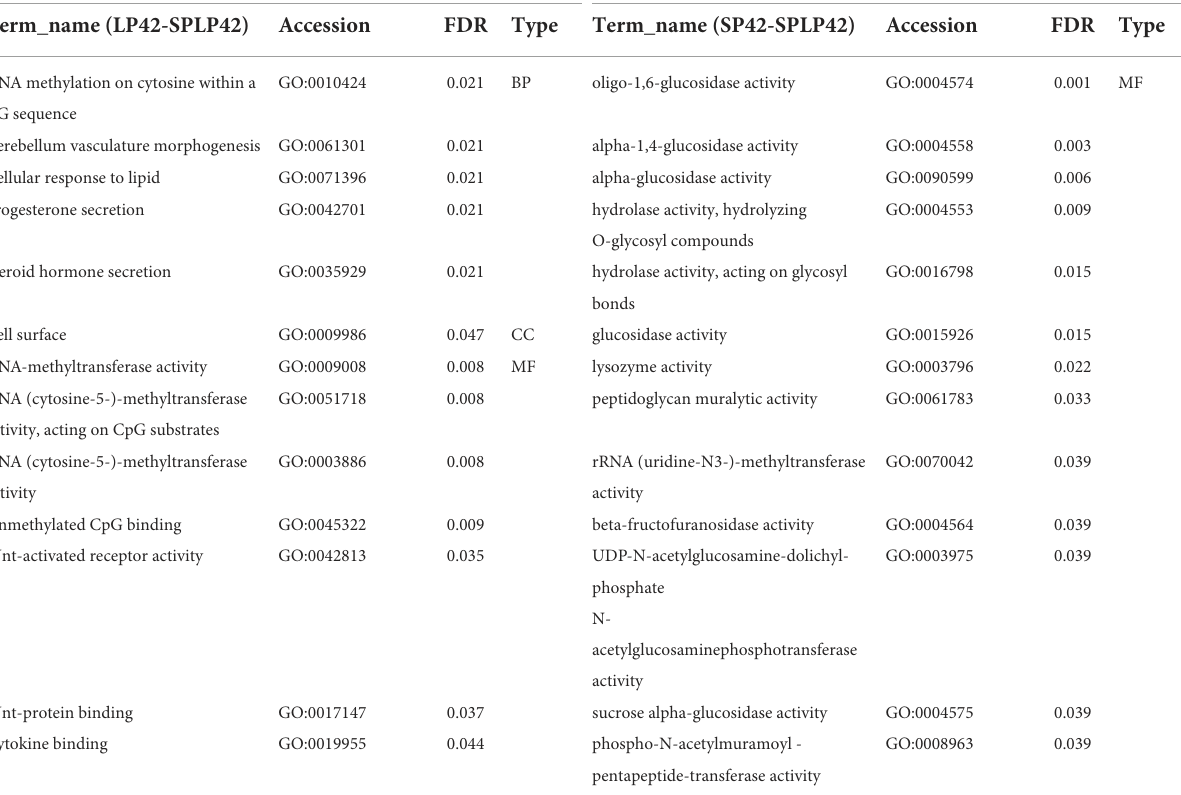
TABLE 3 Functional enrichment analysis of target gene of